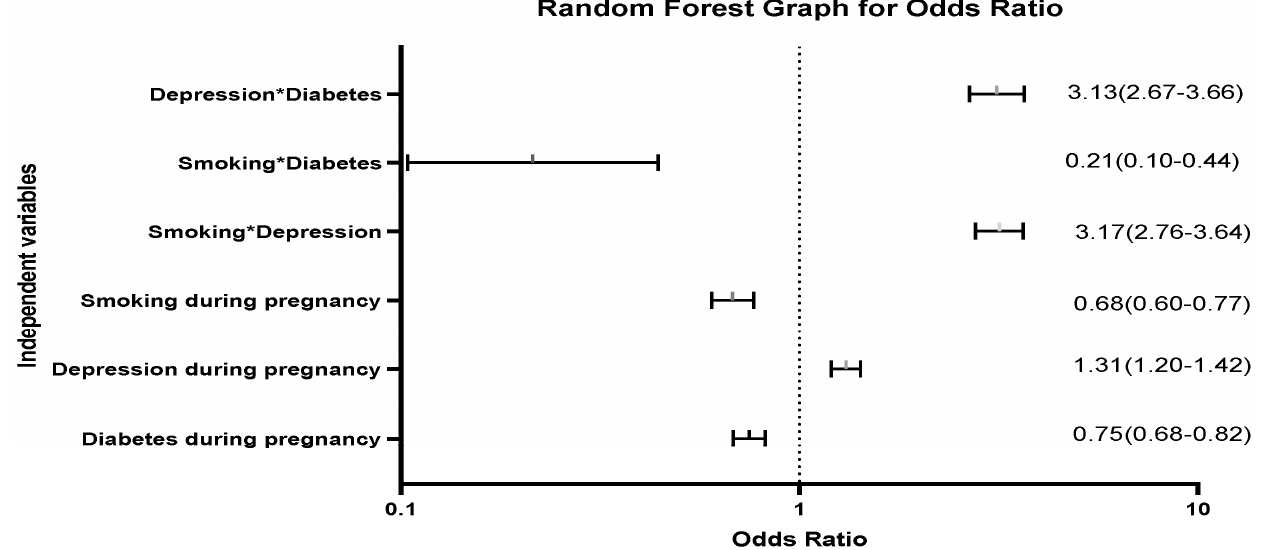
Figure 2. Random forest plot for odds ratio. Note: The figure represents the random forest graph for the odds ratio and corresponding confidence intervals. * Represents the interaction between two variables. Represent the confidence interval of odds ratio.